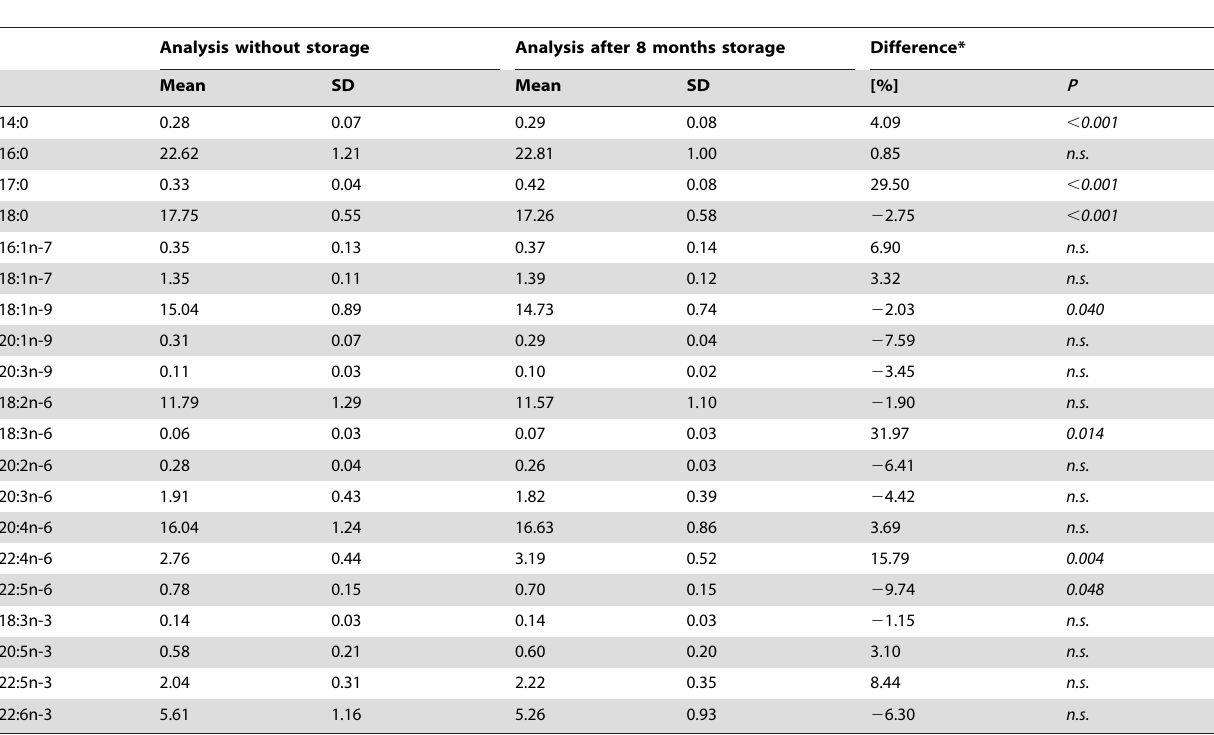
Table 2. Changes in fatty acids (%wt/wt) during storage of RBC samples (n=13) in methanol over a period of 8 months at 2 80 u C.